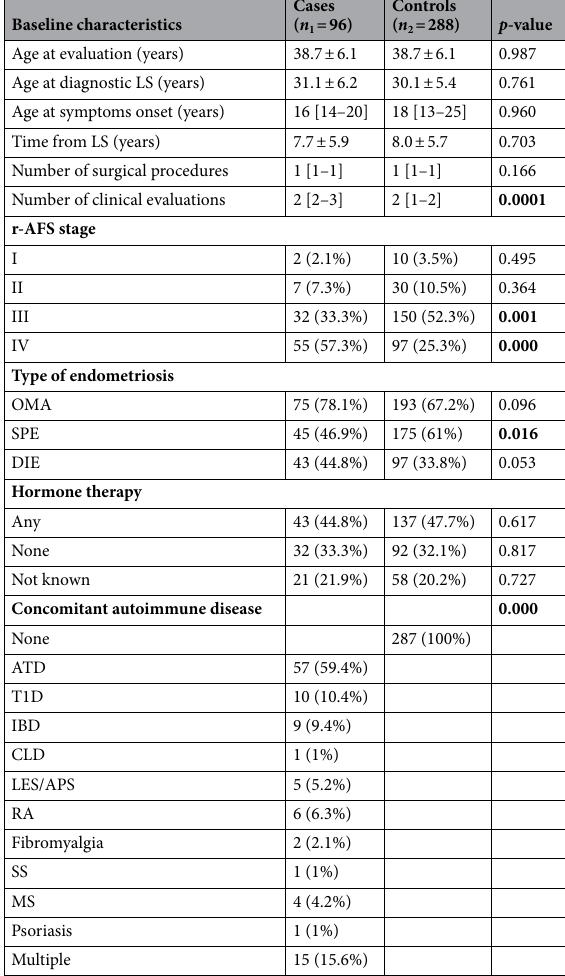
laparoscopic surgery; r-AFS, revised American Fertility Society; OMA, ovarian endometrioma; SPE, superficial peritoneal endometriosis; DIE, deep infiltrating endometriosis; ATD, autoimmune thyroid disorders; T1D, type 1 diabetes; IBD, inflammatory bowel diseases; CLD, coeliac disease; SLE, systemic lupus erythematosus; APS, antiphospholipid syndrome, RA, rheumatoid arthritis; SS, systemic sclerosis; MS, multiple